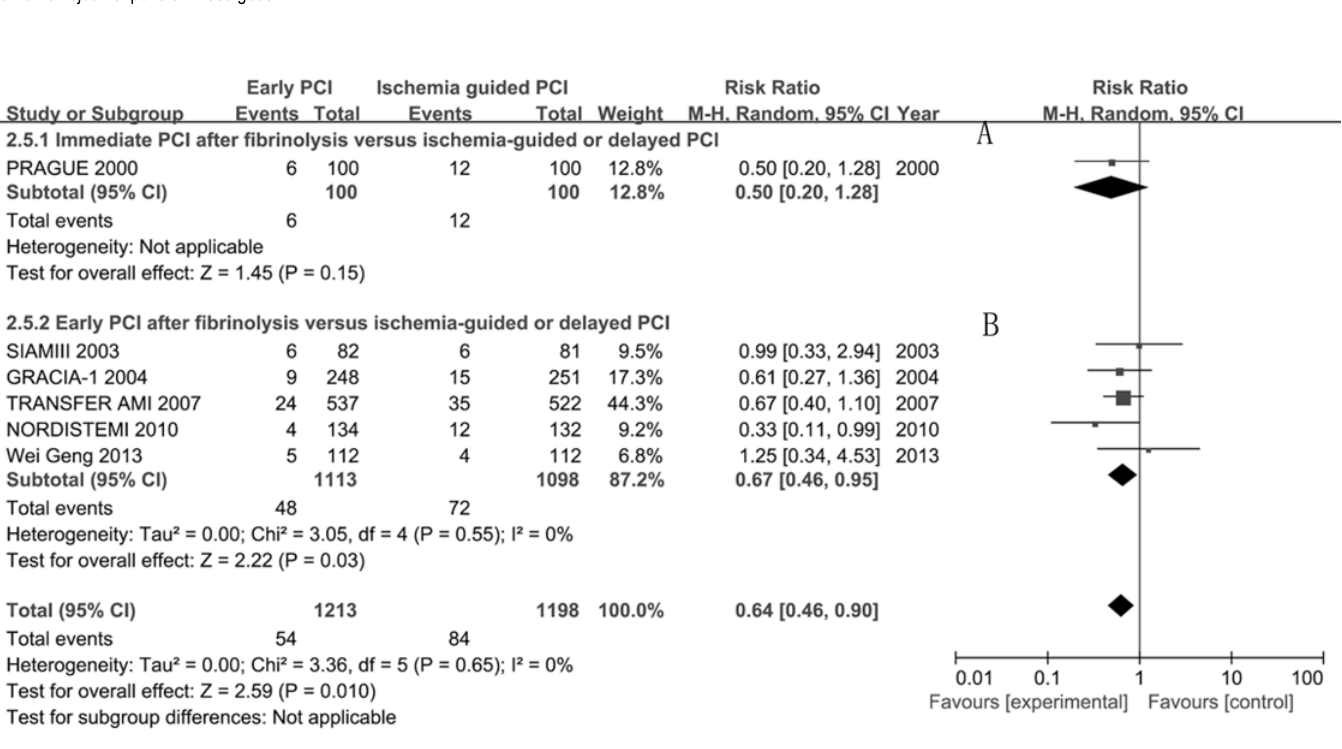
PLOS ONE | DOI:10.1371/journal.pone.0141855 November 2,